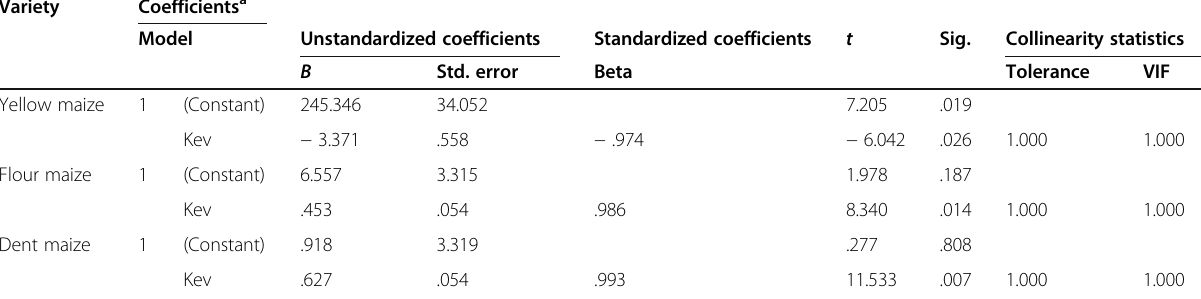
Table 3 Regression coefficients on the yellow maize, flour maize and dent maize varieties for effect of X-ray irradiation on the daily emergence of new progenies of S . zeamais after exposure Variety